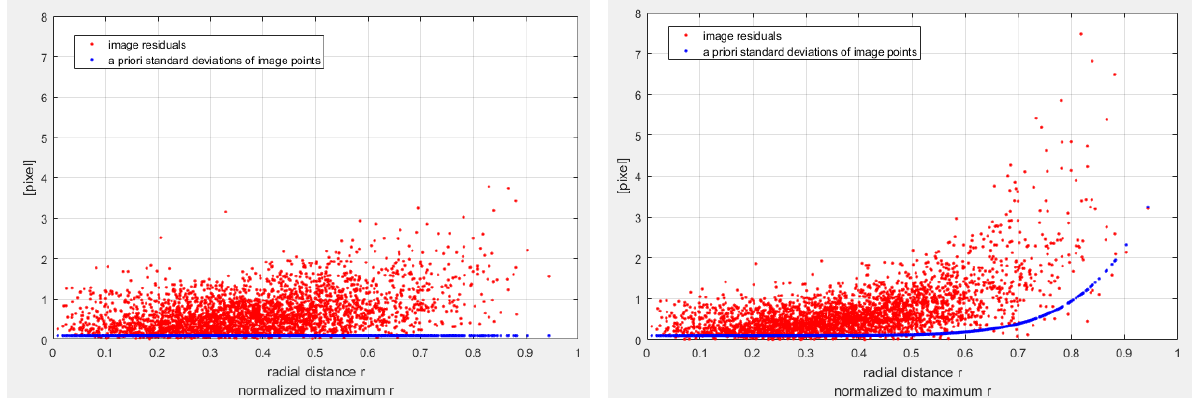
Figure 8. Absolute magnitude of image observation residuals (red) as function of the normalised radial distance from the BA results for the dataset #1_Cal_FLAT Quercianella . The blue curves represents respectively the constant weight of 0.1 pixels provided to the image observations (left) and the empirical weighting function